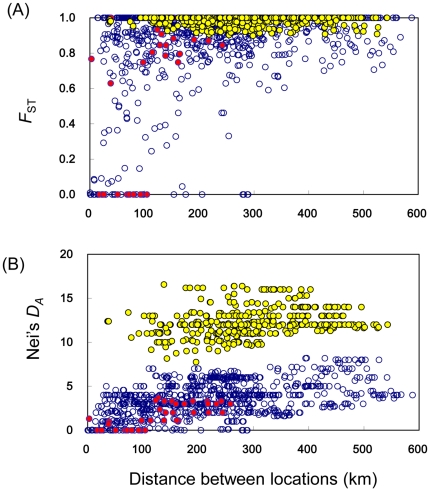
Correlation between geographic distance and genetic distance (upper panel A for F
ST, lower panel B for D
A) for tests of isolation-by-distance in the Japanese crayfish.Open, red and yellow circles represent comparisons within the western lineage, within the eastern lineage and between the lineages, respectively. F
ST and Nei's D
A within western lineage, within eastern lineage and between the lineages all showed significant positive correlations with geographic distance (see text).